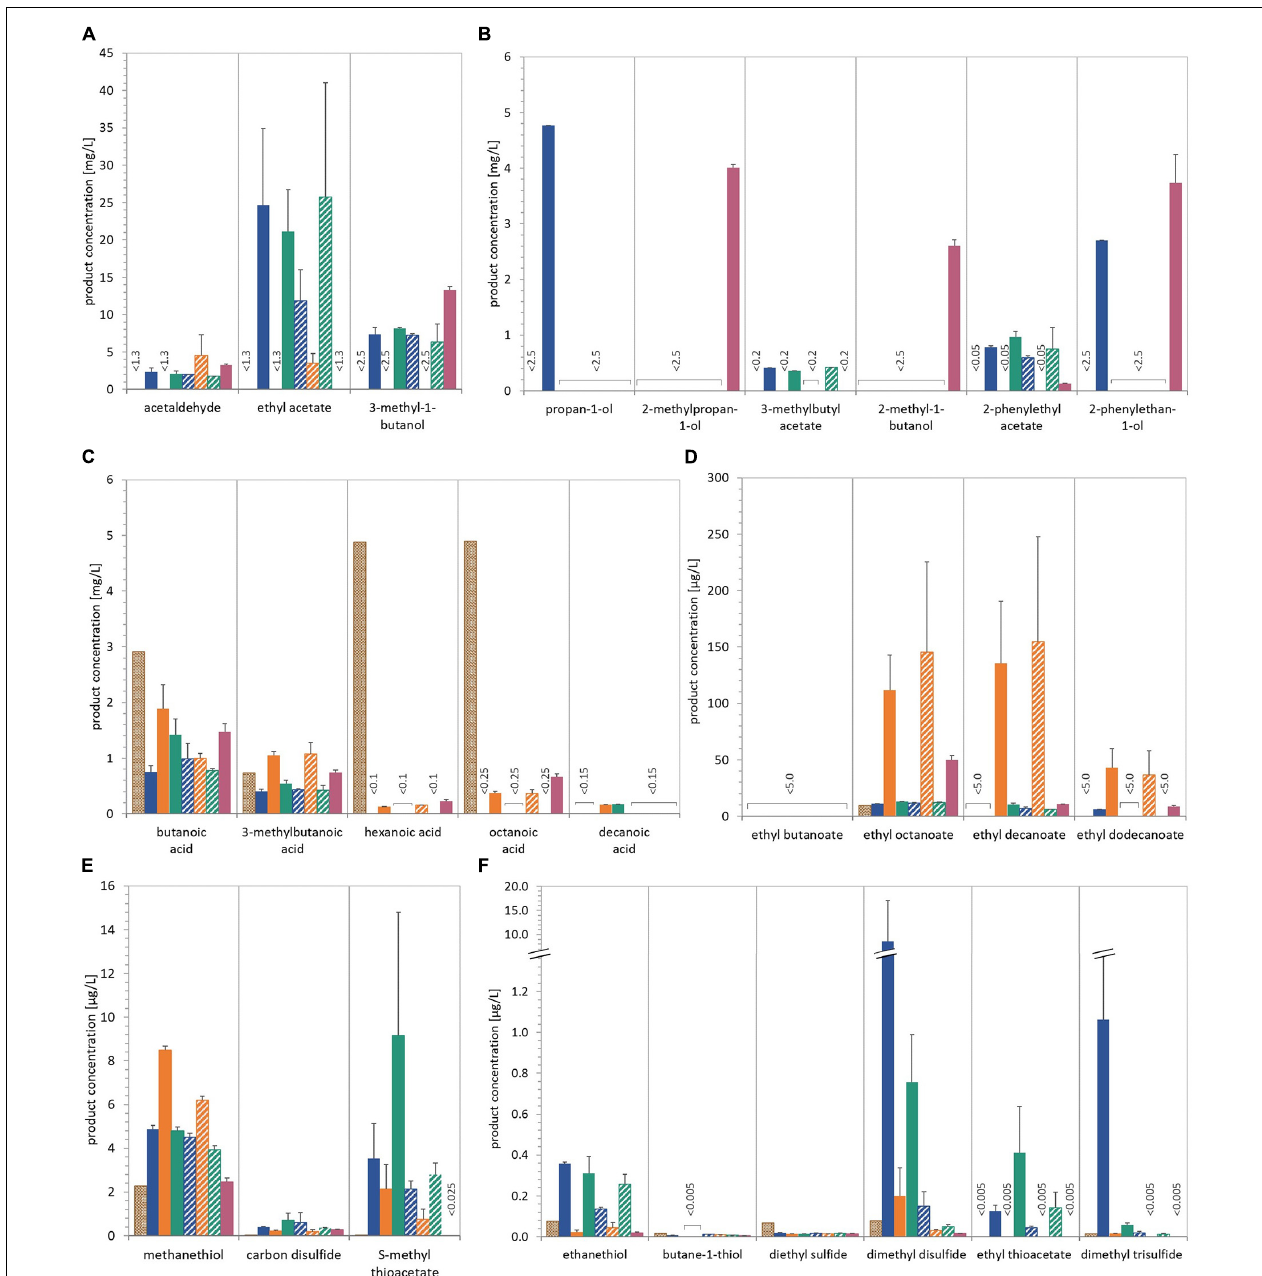
FIGURE 3 | Concentrations of different selected volatile components in the unfermented basis medium and beverages produced with different LAB–yeast combinations and WK grains after 7 and 4 days of fermentation, respectively. The quantified aroma-relevant analytes included higher aliphatic alcohols and esters (A,B) , fatty acids (C) , fatty acid ethyl esters (D) , and thiols and other sulfur components (E,F) . The detection limit is specified for the components for which no detection was possible. The analytes pentanoic acid, dodecanoic acid, ethyl hexanoate, and propane-1-thiol (all not shown) were not detected in any sample. Data of the fermented products are the mean value of biological duplicates ± mean deviation. WK, water kefir; LAB, lactic acid